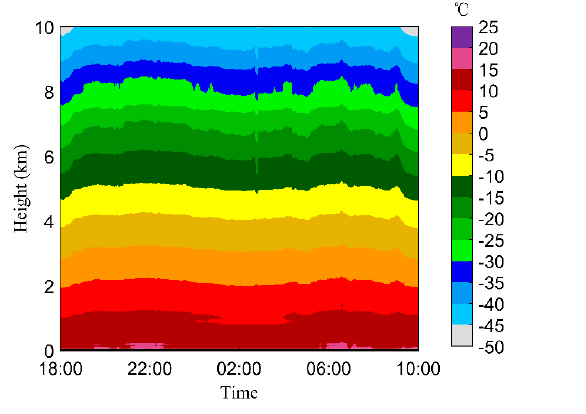
Figure 8. Time – height cross-sections of stratiform rain detected by MRR from 18:00 on 18 August 2021 to 9:30 on 19 August 2021: ( a ) reflectivity factor Z (dBZ), ( b ) mass-weighted mean diameter (mm) and ( c ) DSD at 400 m.